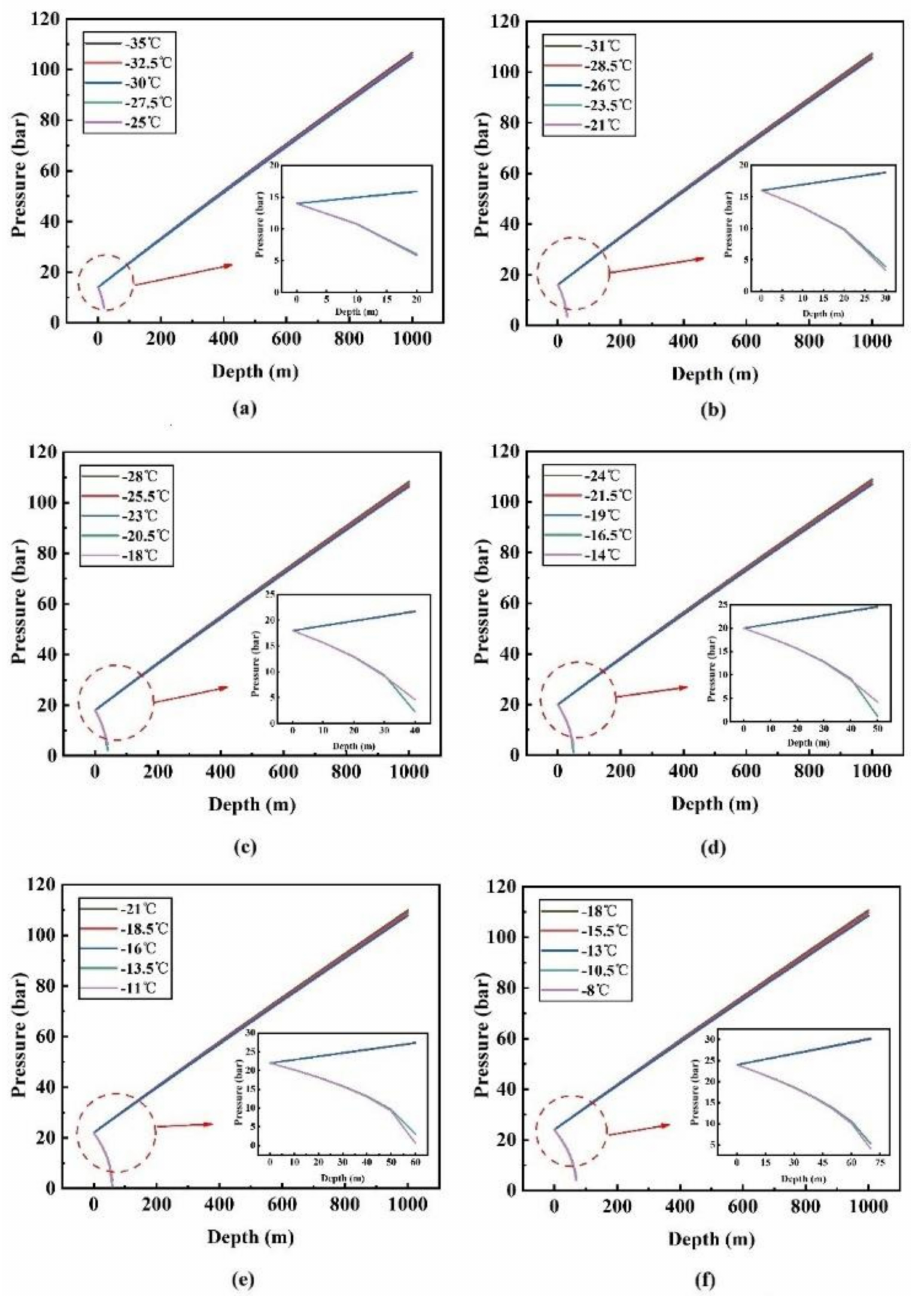
Figure 9. Pressure variation along the pipeline at di ff erent inlet temperatures and di ff erent inlet pressures: ( a ) 14 bar; ( b ) 16 bar; ( c ) 18 bar; ( d ) 20 bar; ( e ) 22 bar; ( f ) 24